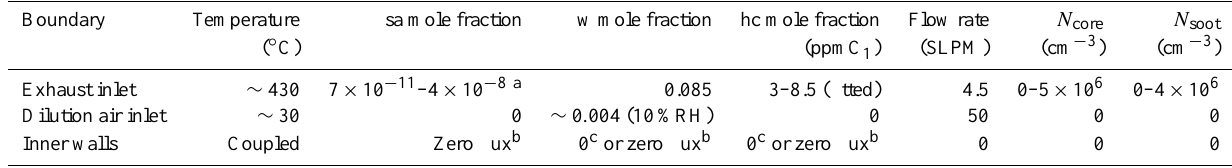
Table 1. Boundary conditions for the simulations. Boundary Exhaust